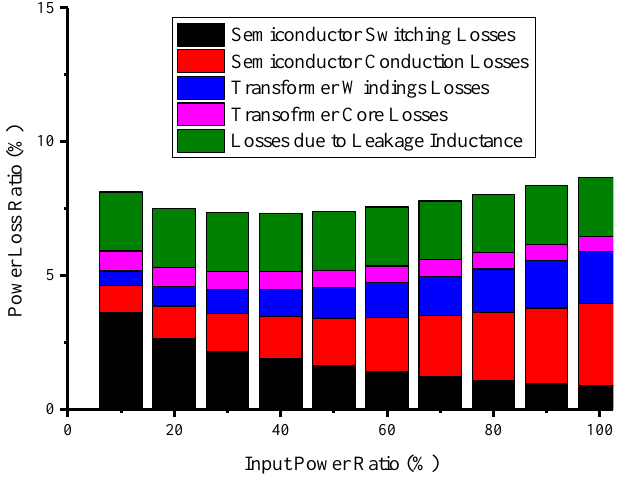
Figure 10. Power losses based on the theoretical analysis ( V dc = 40 V).